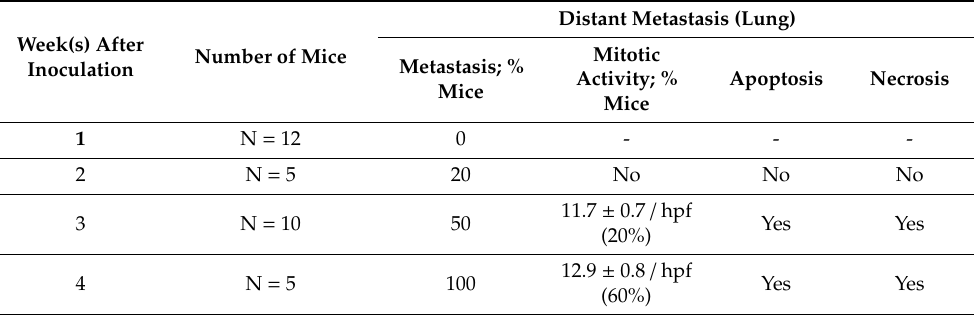
Table 2. Histological detection of lung metastasis.